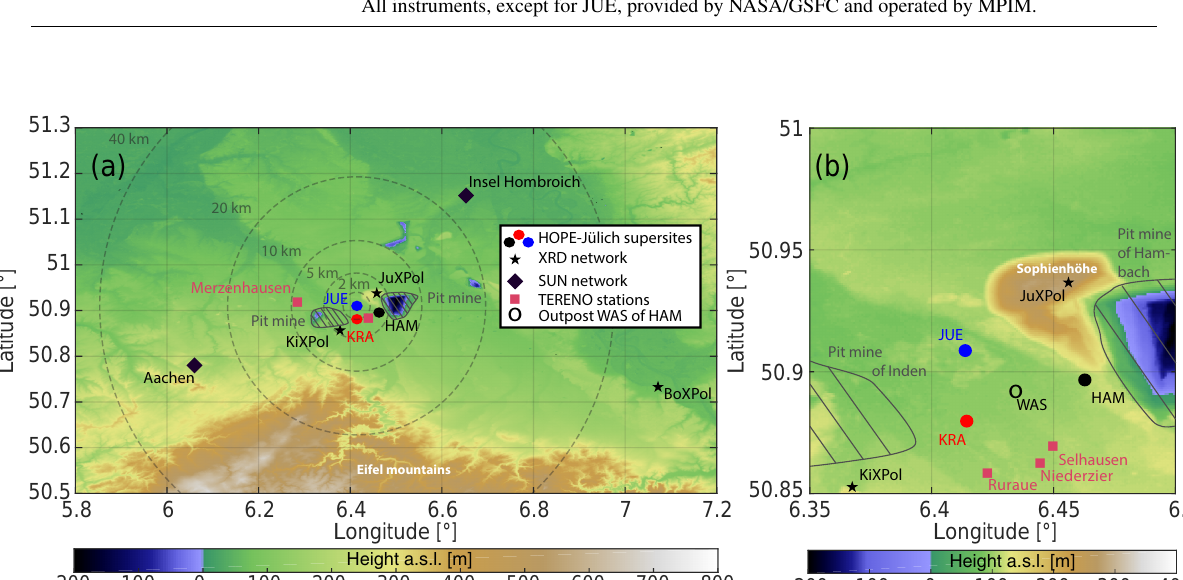
Figure 3. Map of the spatial distribution of the measurement sites and networks deployed according to Table 1 (a) and a zoomed-in view centred at supersite Jülich (b) . Background colours indicate the topography and dashed lines denote circles of constant distance from supersite Jülich (JUE). Shaded areas denote open-pit mines, for which the elevation map is not up to date.